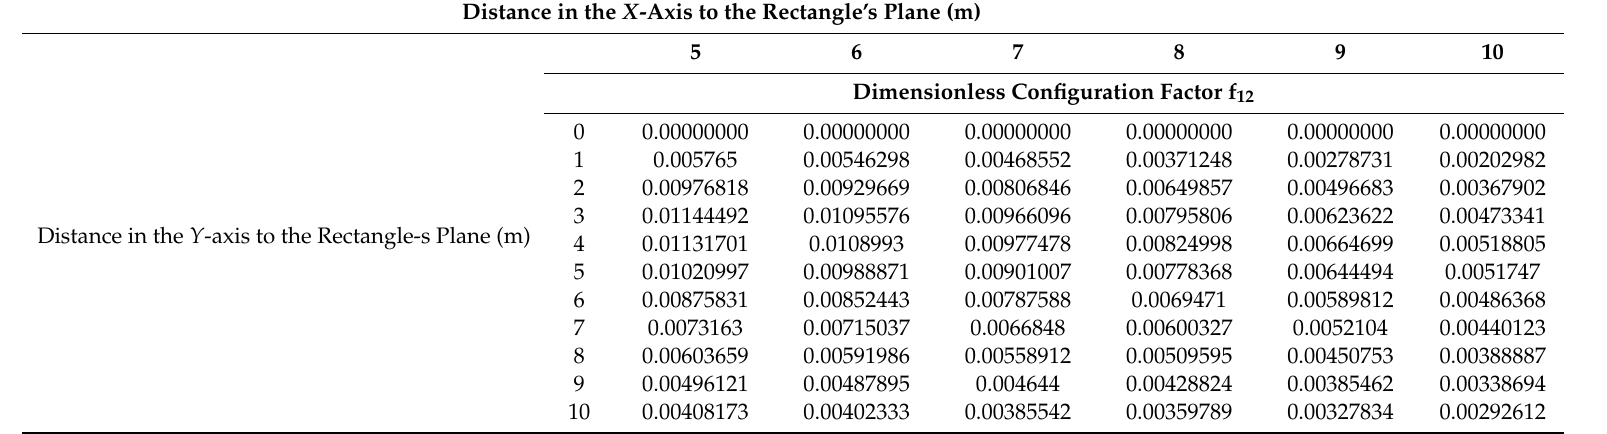
Table 2. Configuration factors of an area of 5 × 10 m 2 (the values that are omitted are obviously symmetrical) illuminated by a ‘rectangle’ of 2 × 2 m 2 . Values obtained by analytical methods ([6], pp.